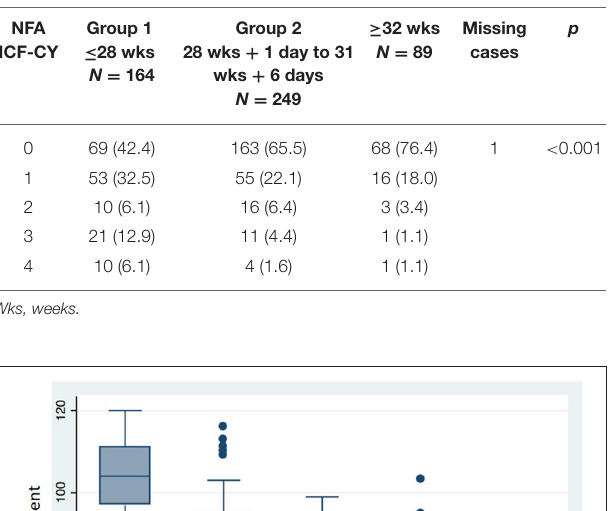
TABLE 6 | Neuro-functional clinical evaluation: results according to different gestational age groups.